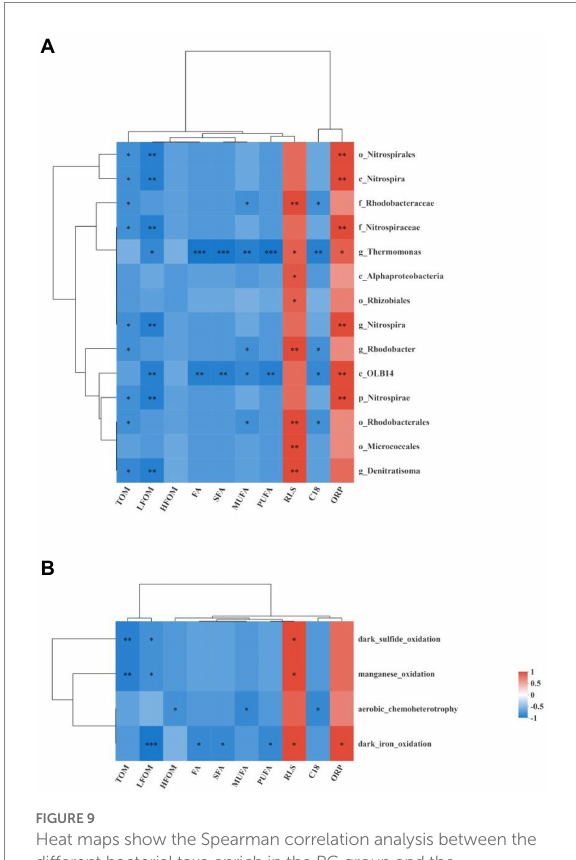
FIGURE 9 Heat maps show the Spearman correlation analysis between the different bacterial taxa enrich in the PG group and the environmental factors (A) and the Spearman correlation analysis between the different functional group and the environmental factors (B) . * , ** , and *** denote significance at 0.05, 0.01, and 0.001 level, respectively. C18 indicated the C18:1-3/C18:0